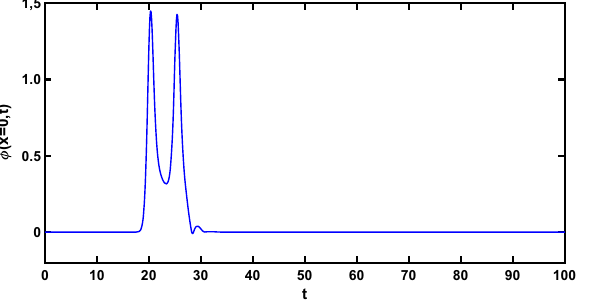
Fig. 16 Antikink-kink scattering: Scalar field φ( x = 0 , t ) at the colli- sion center as a function of time for n = 7 with v = 0 . 6